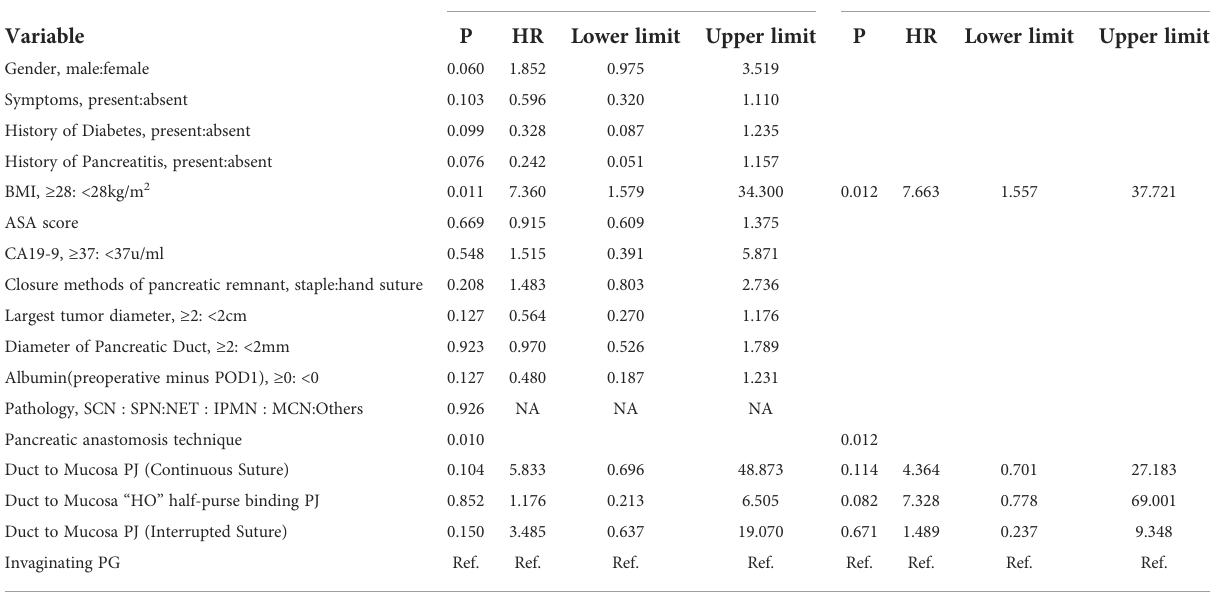
TABLE 2 Univariate and mutivariate factor analysis for